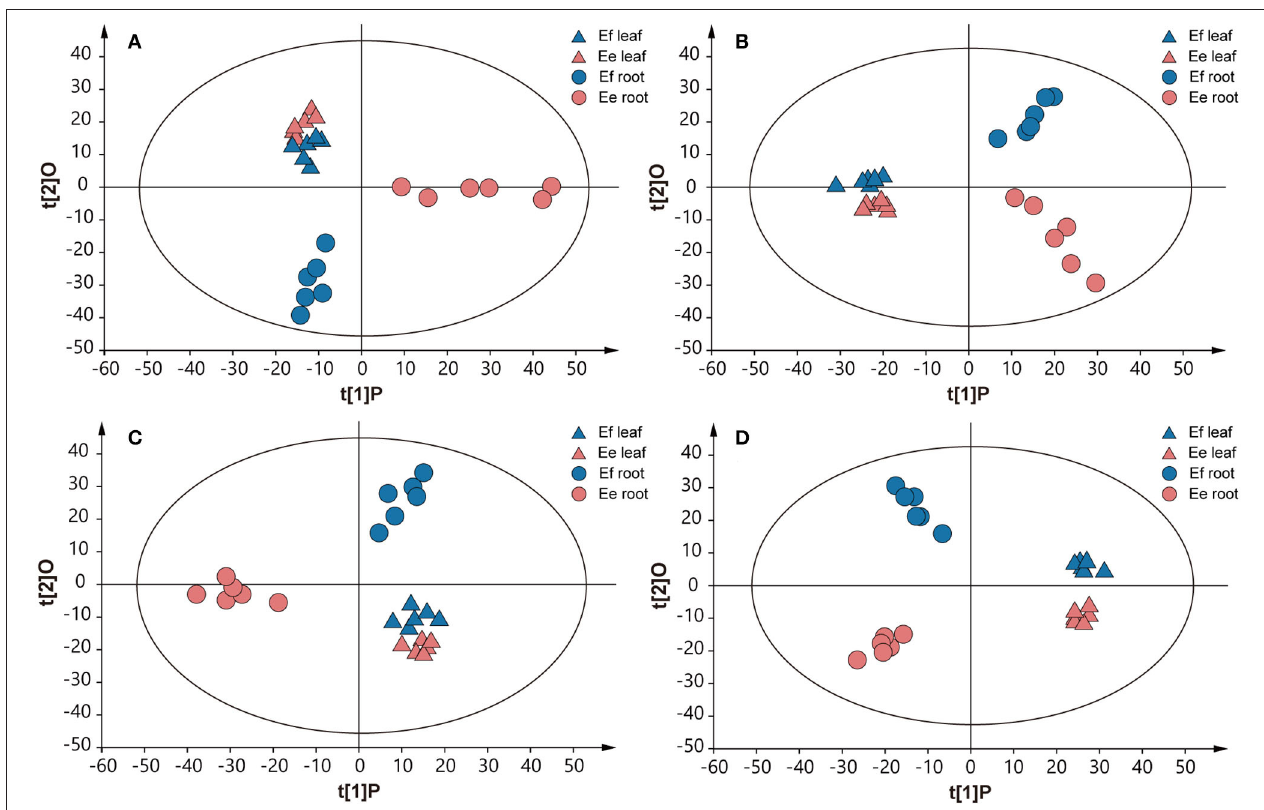
FIGURE 5 | Score plots of PCA and OPLS-DA. (A) PCA in positive mode. (B) PCA in negative mode. (C) OPLS-DA analysis in positive mode. (D) OPLS-DA analysis in negative mode. Multivariate analysis of metabolic profiles of root and leaf samples from E. fischeriana and E. ehracteolata with 6 biological replicates.